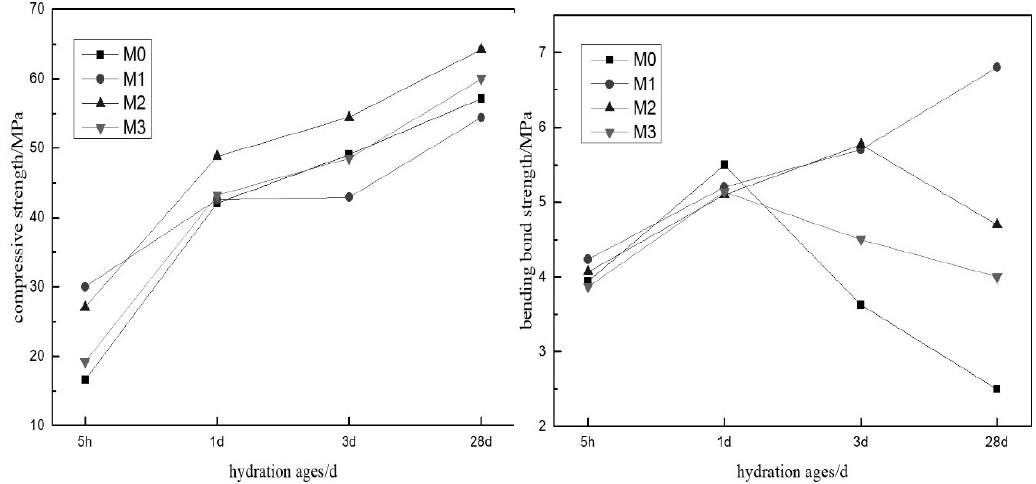
Figure 1. Compressive strength and bending bond strength of potassium magnesium phosphate cement (MKPC) mortar with mineral mixed materials.